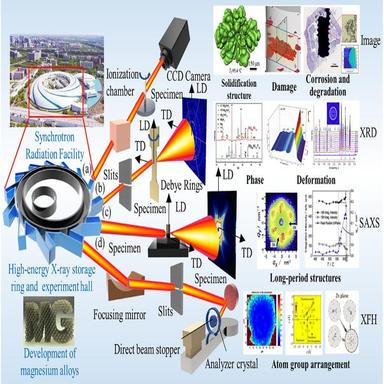
Schematic principle of synchrotron radiation technique and its application in Mg alloy research. (a) Synchrotron radiation X-ray imaging. (b) Synchrotron radiation X-ray diffraction . (c) Synchrotron radiation small angle X-ray scattering . (d) Synchrotron radiation X-ray fluorescence holography .